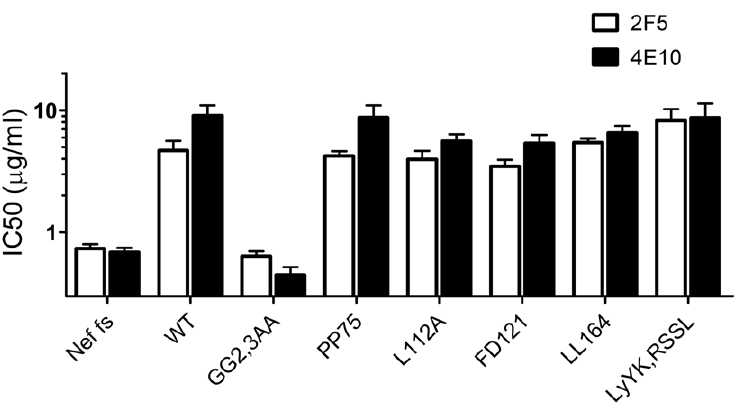
Figure 9. Nef myristoylation is required for its activity on neutralization. IC50 of 2F5 and 4E10 for HIV-1 NL4-3 pseudotyped with Env JRFL and carrying the indicated Nef mutations. Values were derived from the sigmoidal curves shown in Figure S6. Neutralization was performed three times independently. Shown are the mean values and SD.